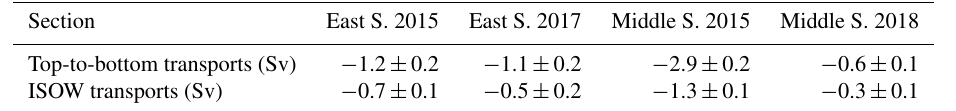
Table 3. Geostrophic top-to-bottom and ISOW transports (Sv) across the East and Middle sections. ISOW is defined by σ 0 > 27.8kgm − 3 and salinity higher than 34.94. Errors are estimated following Petit et al. (2018).